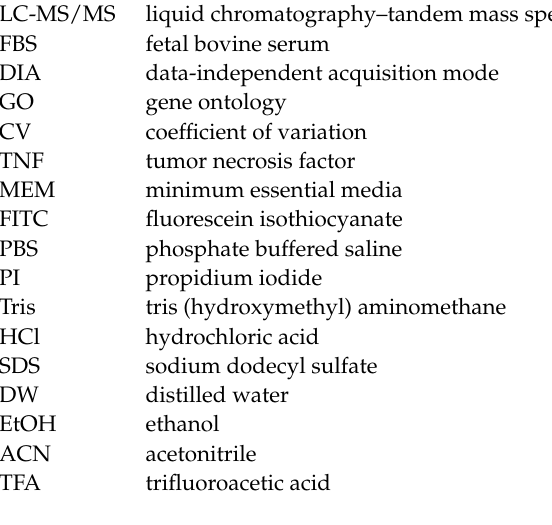
Figure S2: Reproducibility of proteome analyses by different treatments, Figure S3: Molecular function GO enrichment analysis of the significantly regulated proteins by TNF